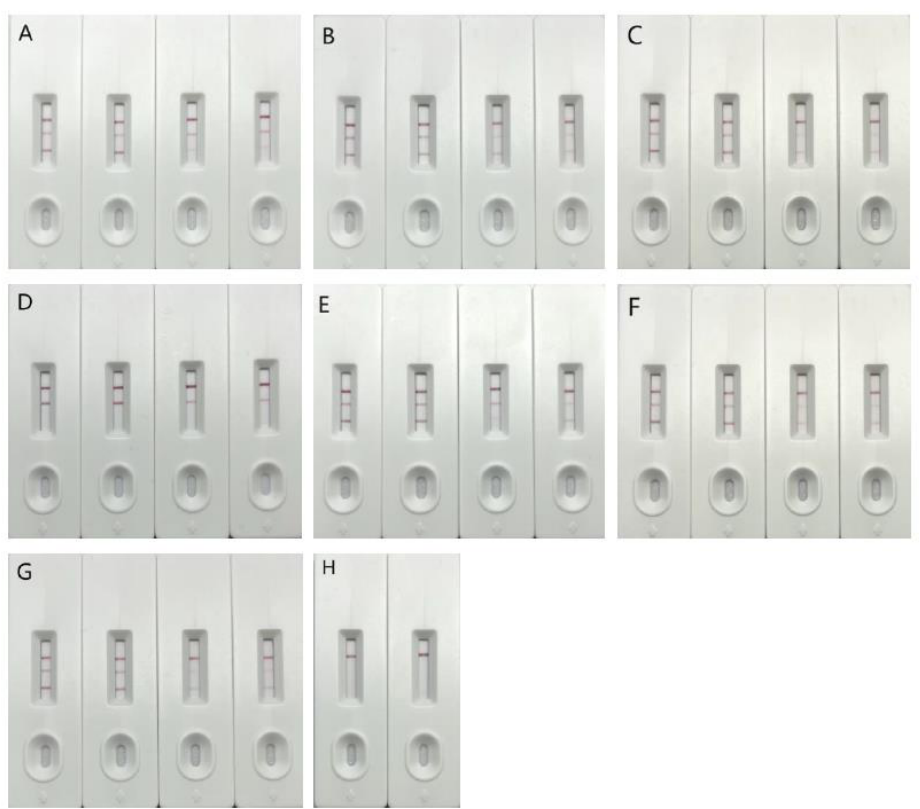
Figure 1. Detection result of single card with double T test line. Note: In the above detection results, ( A ) detection of the original strain, ( B ) detection of the β strain, ( C ) detection of the δ strain, ( D ) detection of the o strain, ( E ) detection of the original strain mixed with o, ( F ) detection of the β strain mixed with o, ( G ) detection of the δ strain mixed with o, ( H ) detection of the negative control. The three detection lines in the figure are, respectively, C, T2 and T1 lines from top to bottom, where C is the quality control line, T line is the detection line, T1 is the undetectable Omicron line, and T2 is the detectable Omicron line. Table 5. Test strip cross-reaction validation